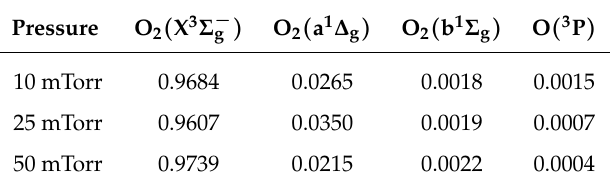
Table 2. The partial pressures of the thermal neutrals at 10, 25, and 50 mTorr for the wall quenching (volume averaged) model.